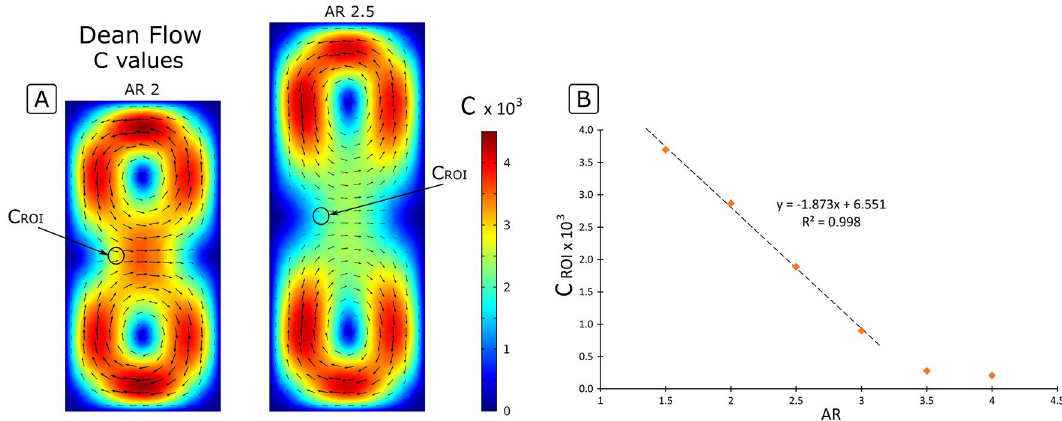
2 W 2 / R . The color m